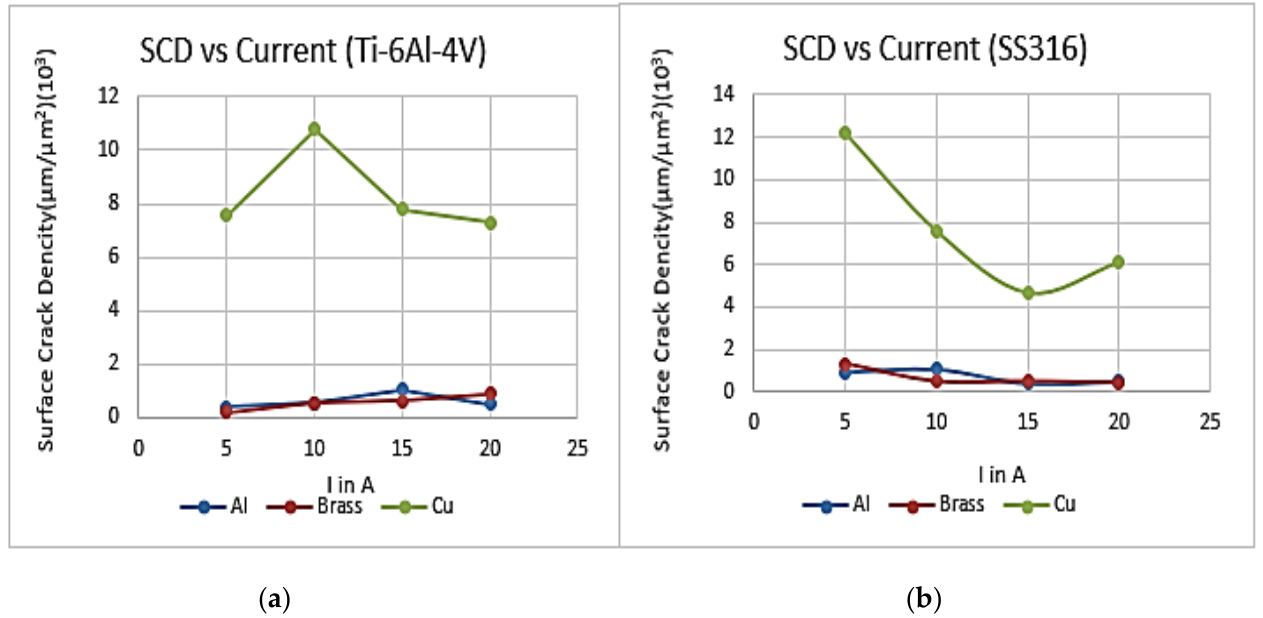
Figure 12. Variations of SCD for ( a ) Ti-6Al-4V and ( b ) SS316 using different tools.